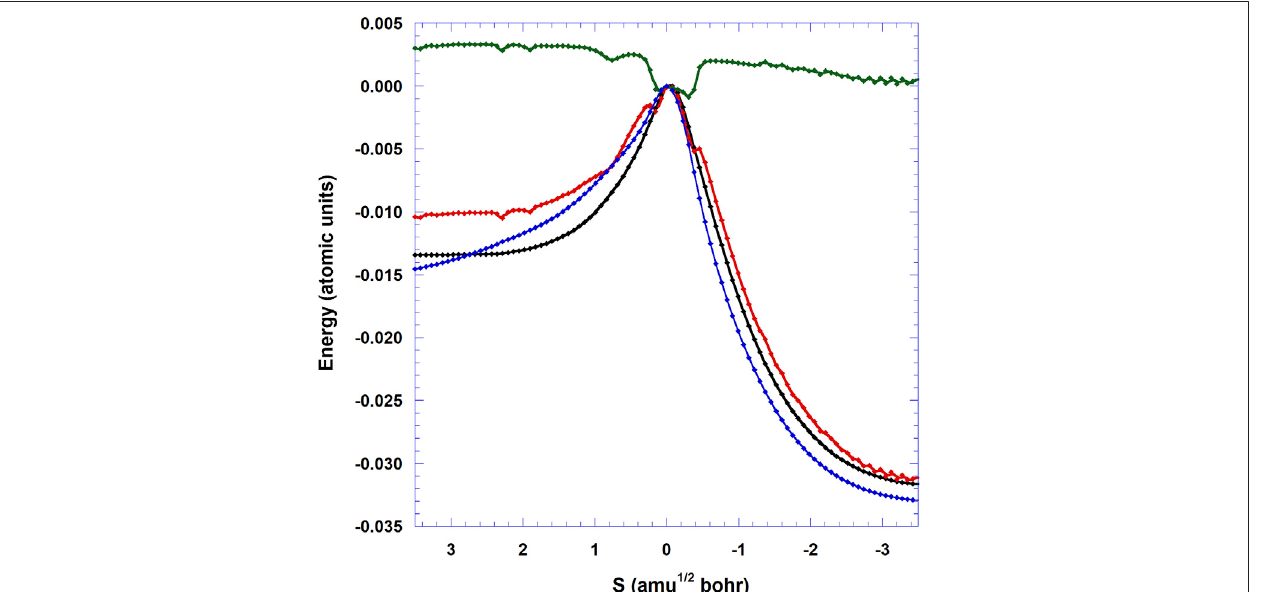
FIGURE 6 | Minimum energy path V MEP (blue: ONIOM(M05-2X:Amber) level, black: CBS/DLPNO-CCSD(T)//ONIOM(M05-2X:Amber) level), vibrational adiabatic potential energy (V G a , red), and Δ ZPE (green) of the 3N-6 vibrational modes with respect to TS as functions of (s) (amu 1/2 a 0 ). The energy of the TS is set to 0.